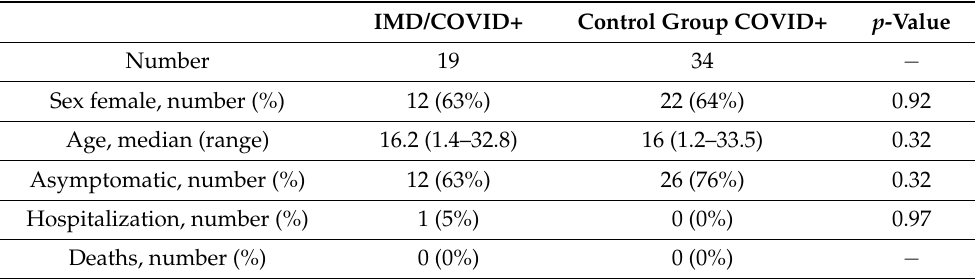
Table 2. Comparison of the main parameters between the IMD and control